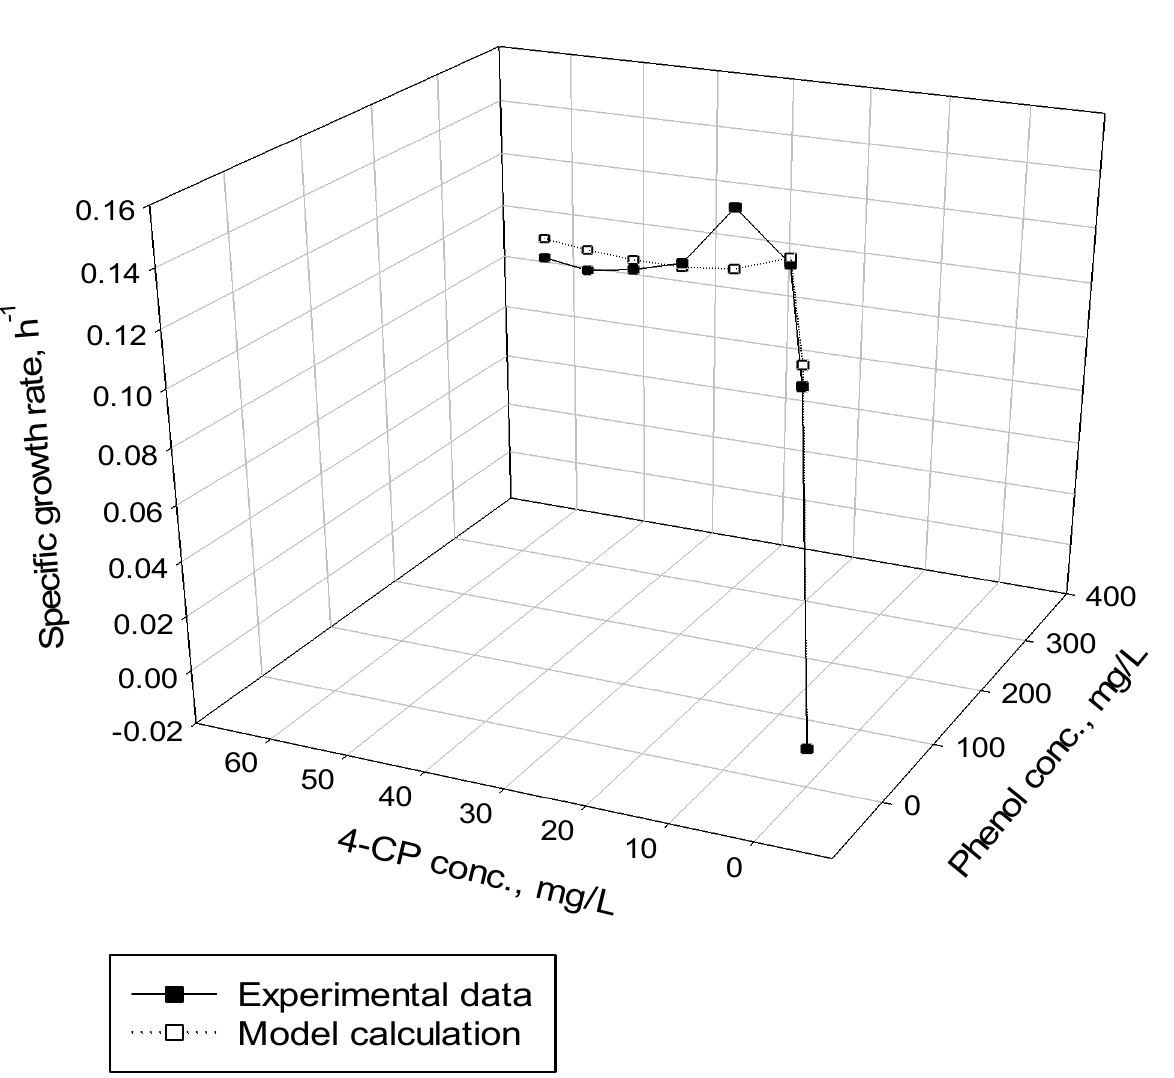
Figure 9. The specific growth rate in the cometabolic system was fitted by competitive inhibition model to determine the competitive inhibition coefficients of phenol and 4-CP, respectively. Table 1. Summary of the kinetic constants as well as the operation conditions for the model prediction.